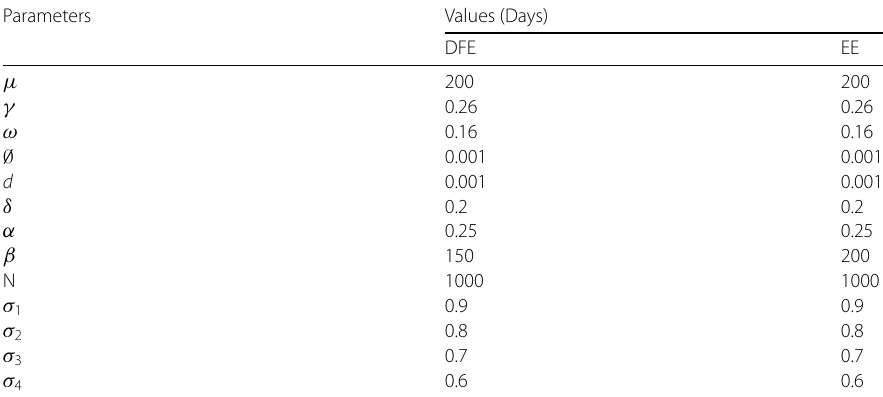
Table 2 Parameter values